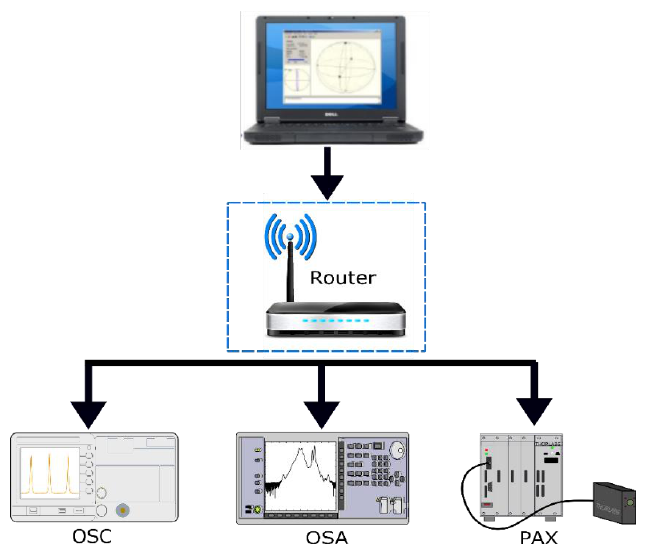
Figure 2. Schematic diagram base for remote communication via LAN with the optical instrumentation. 138